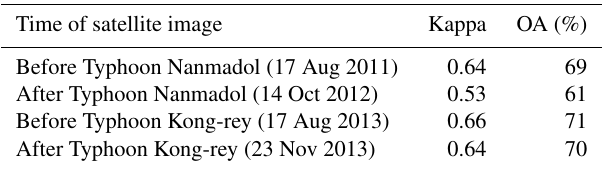
Table 3. Interpretation results of satellite images before and after typhoons Nanmadol and